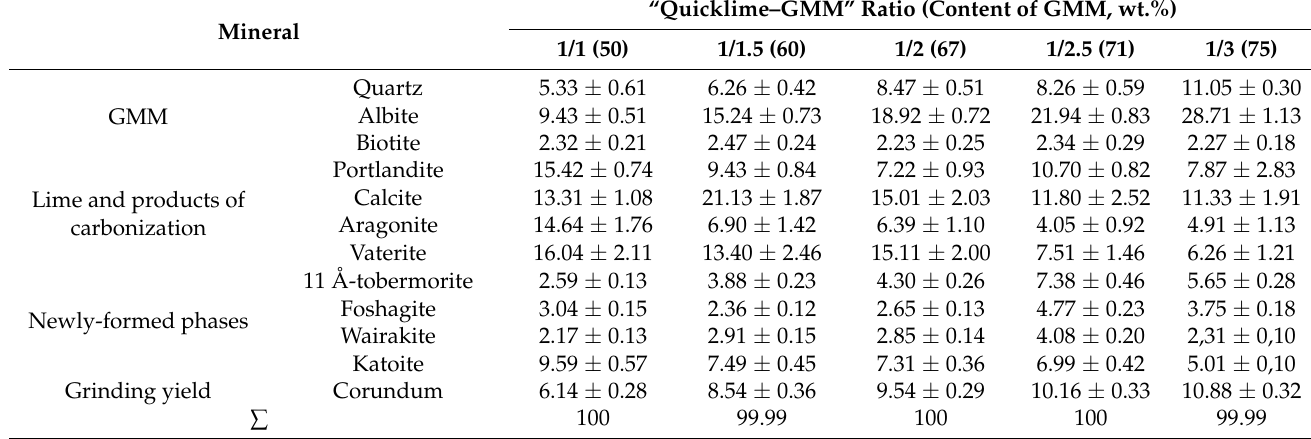
Table 6. Mineral composition of autoclaved “quicklime–GMM” binders